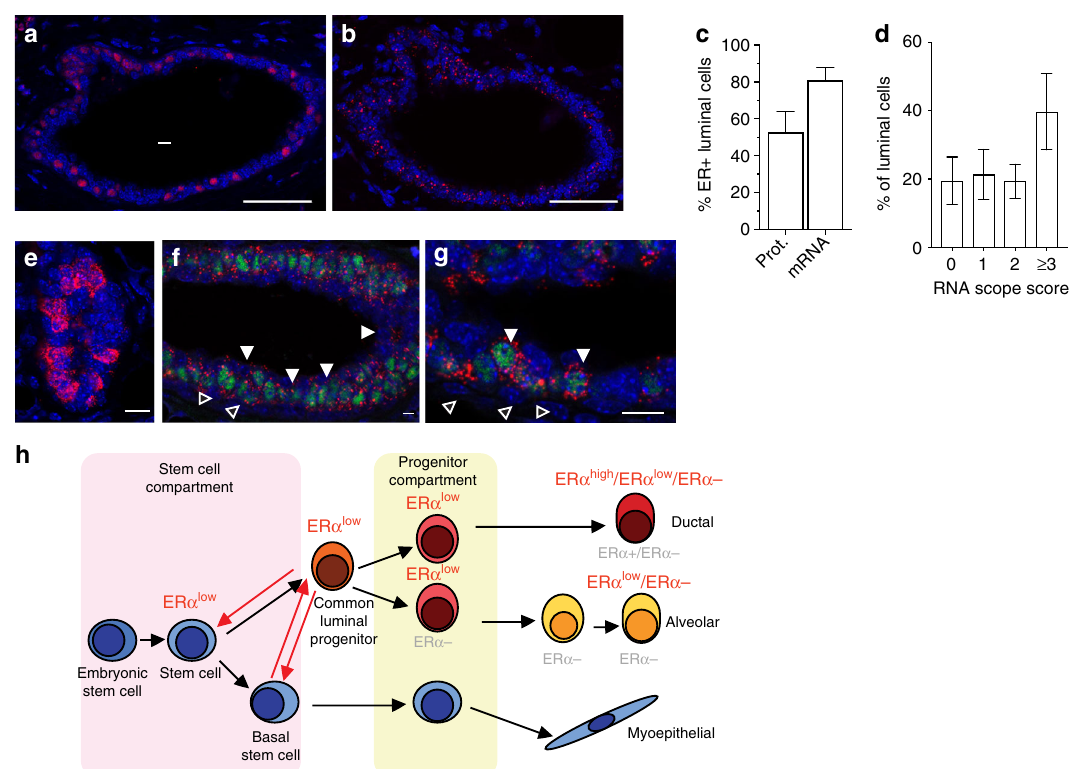
Fig. 9 ER α mRNA and protein expression ER α − / − and WT MECs. a ER α immuno fl uorescence (red) and b RNAscope with anti- Esr1 probes (red) on an adjacent section counterstained with DAPI (blue) on mammary gland from 6-week-old WT female. Scale bars; 50 μ m. c Bar plot showing percentage of luminal cells with detectable levels of ER α protein and Esr1 mRNA at puberty ( n = 5; mean ± SD). d Bar plot showing percentage of luminal cells with different Esr1 RNAscope scores ( n = 5; mean ± SD). e RNAscope with anti- Areg probes (red) counterstained with DAPI (blue) on mammary gland from 6- week-old WT female. Scale bar; 50 μ m. f RNAscope with anti- Esr1 or g anti- Areg probes (red) co-stained with anti-PgR antibody (green) and counterstained with DAPI (blue). Arrowheads point to apically-located luminal cells with ER α transcript but no PgR expression ( f ) and Areg transcript and PgR expression ( g ). Empty arrowheads point to myoepithelial cells f , g . Scale bars; 100 μ m. h Current model of mammary stem cells and the differentiation hierarchy after Visvader, J.E. and Stingl, J. 56 . In grey: previously proposed ER α status of different MEC differentiation stages. In red: ER α status based on the present fi